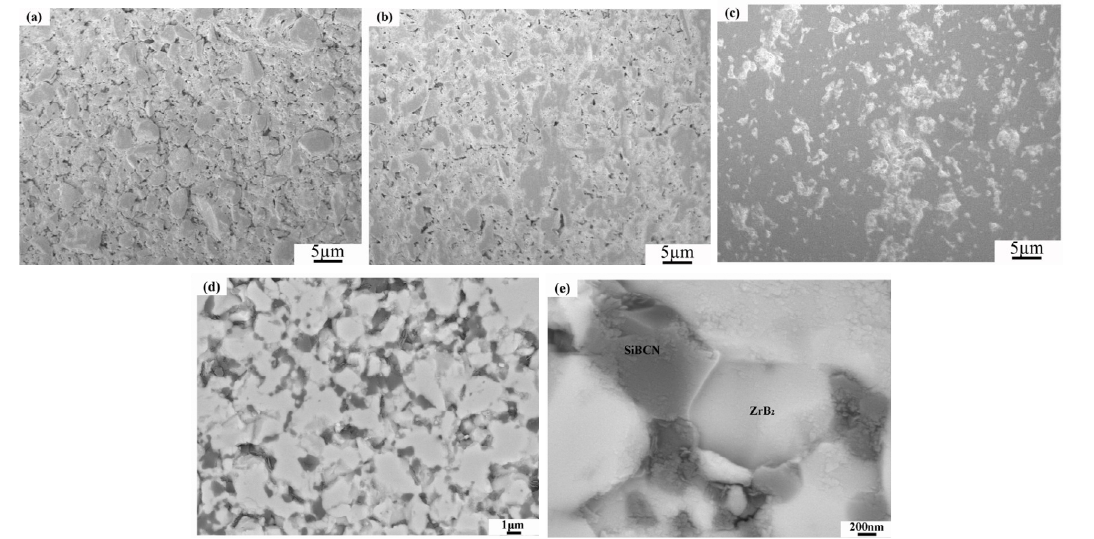
Fig. 4 Microstructure change of ZrB 2 –SiBCN ceramics with 1 wt% ZrO 2 sintered at different temperatures for 90 min: (a) 1300 ℃ , (b) 1400 ℃ , (c) 1600 ℃ , and (d, e) 1600 ℃ (BSE images with large magnification).